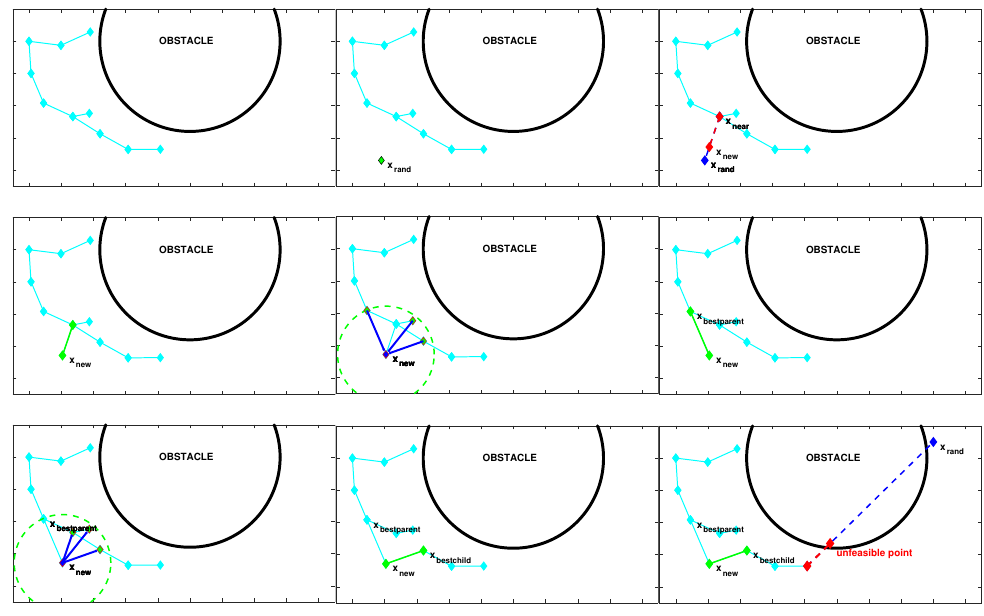
Figure 2. An example of how the RRT* algorithm